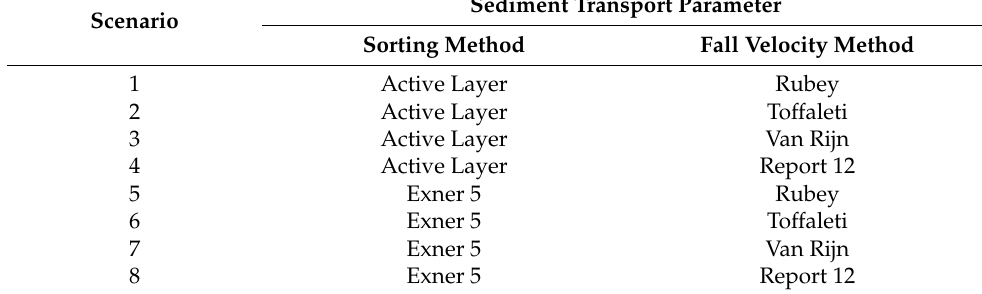
Table 4. Scenarios for the sediment